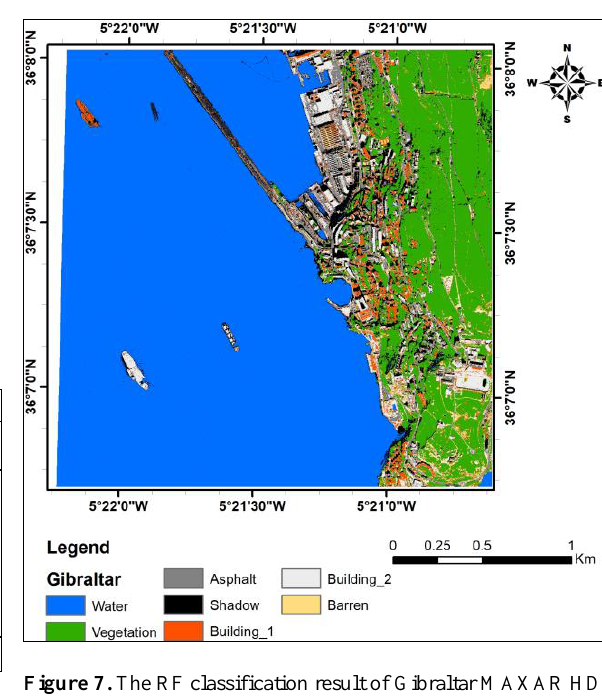
Table 2. Model parameters employed in the study.